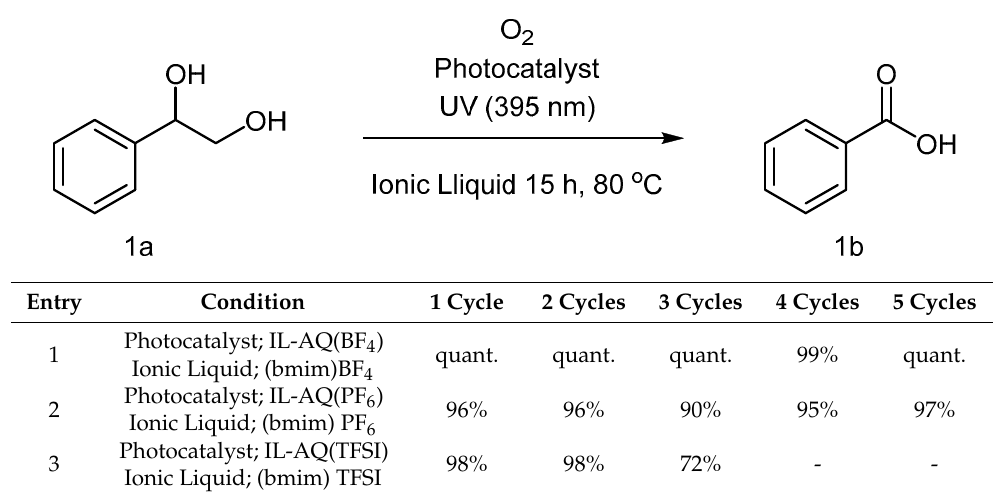
Table 3. Recycling of the ionic liquid-supported catalysts a . a Conditions: 1-phenylethane-1,2-diol